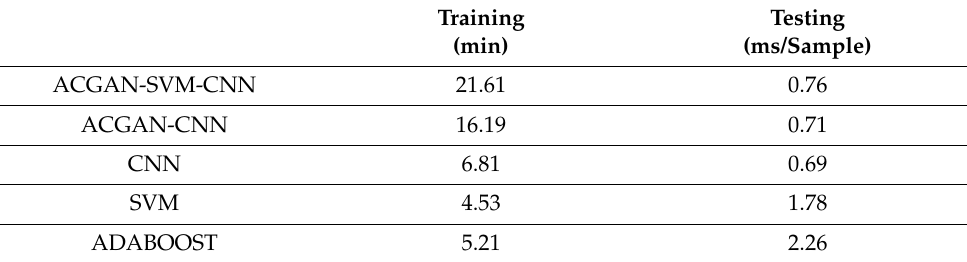
Table 5. Training and testing time of different models.